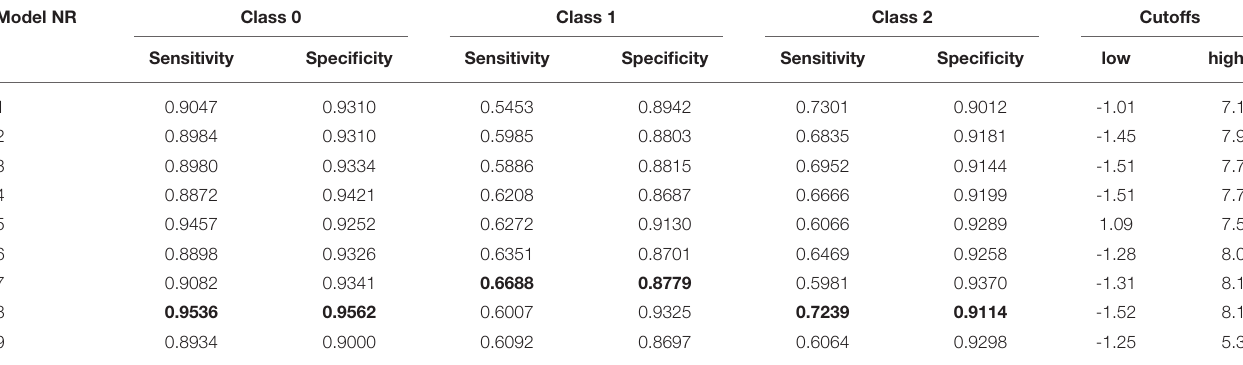
TABLE 5 | Sensitivities and specificities of all models using two cutoffs on probability estimates. Model